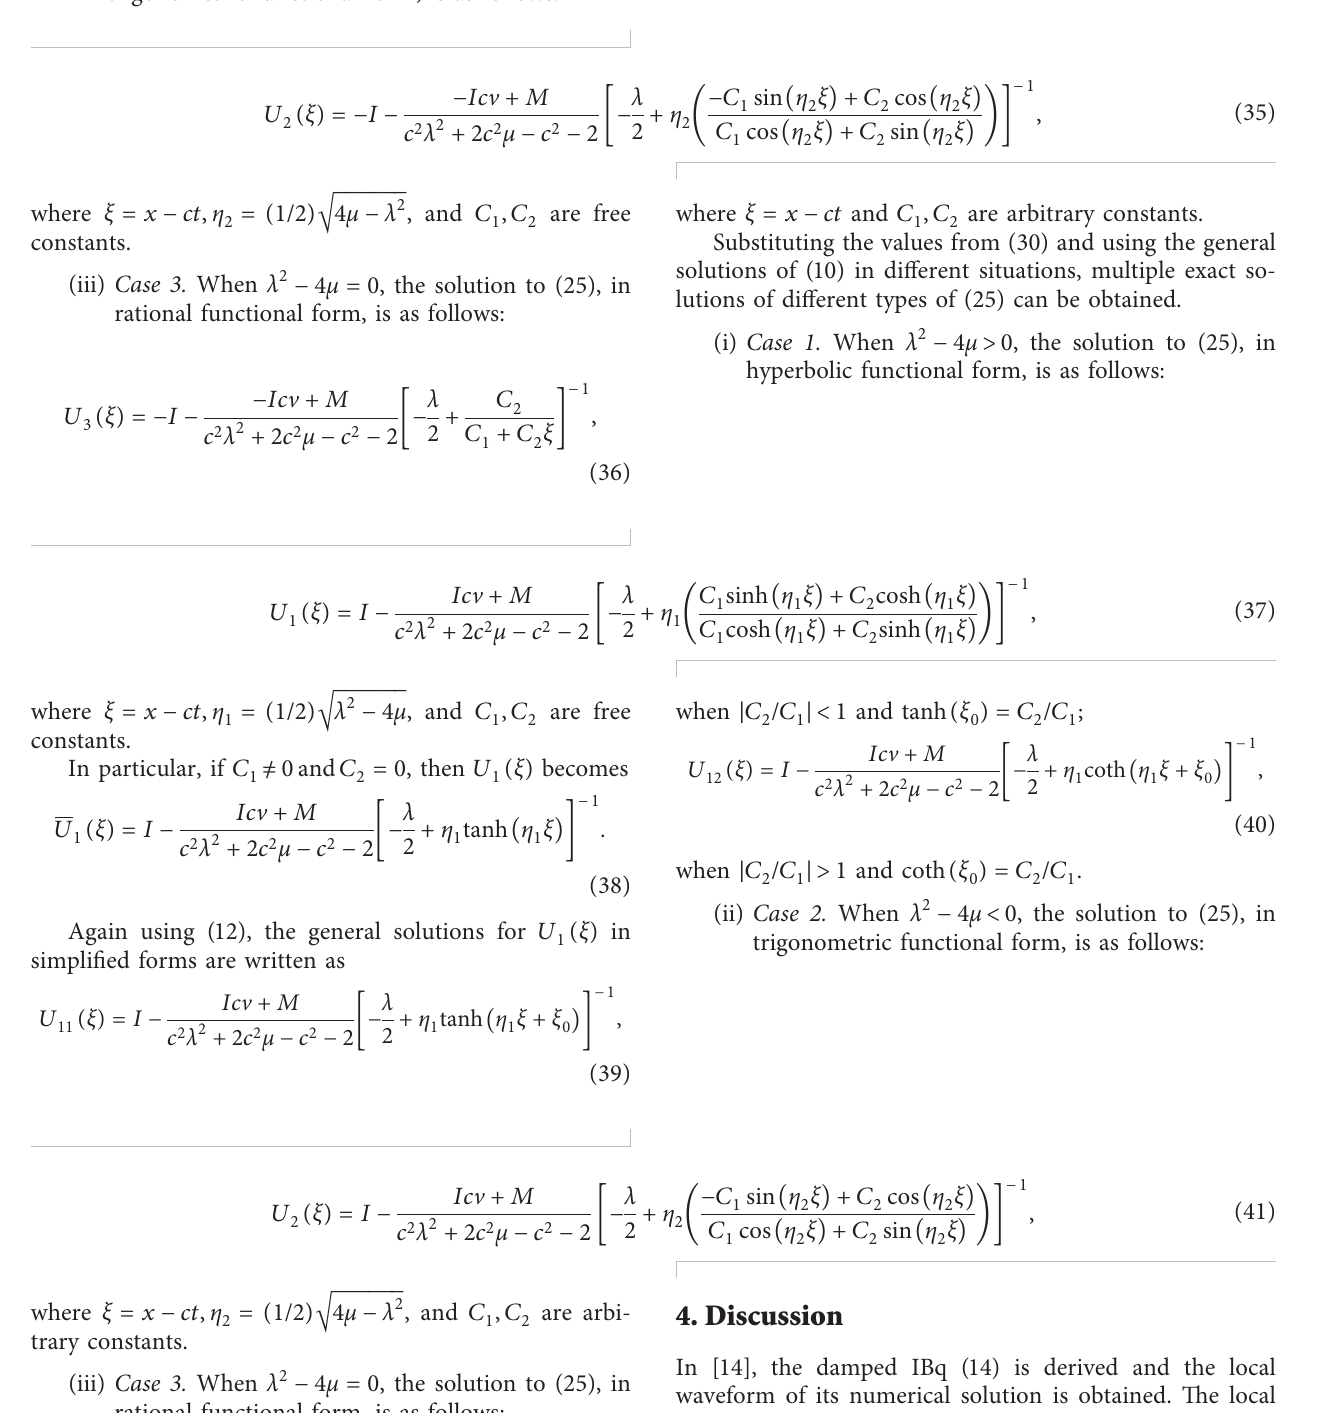
In [14], the damped IBq (14) is derived and the local waveform of its numerical solution is obtained. The local two-dimensional display of the numerical solution is a bell- shaped waveform, similar to the local figure of the two- dimensional figure obtained by taking time as a constant in Figure 1. Figure 1 is a three-dimensional diagram of the trigonometric solution (23). It is well known that numerical solutions may miss some solutions of the equation, as shown in Figure 2, which is a kinked type of isolated wave and is not mentioned in [14]. As can be seen from Figure 2, when